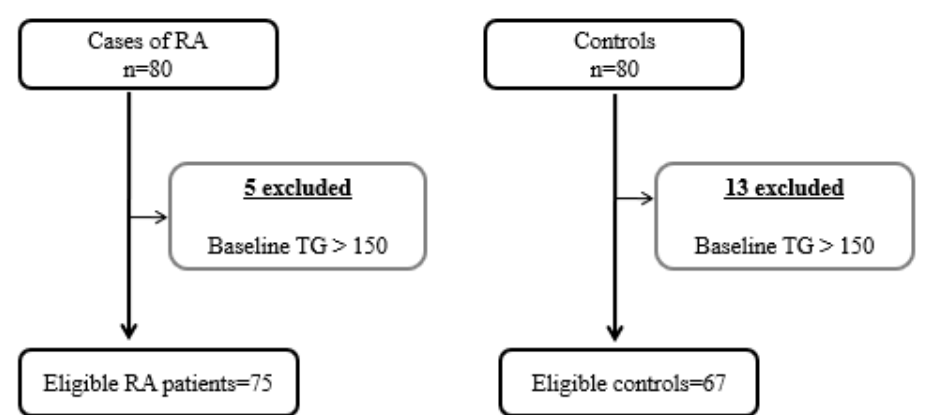
Figure 1. Flowchart showing patients included in the study.